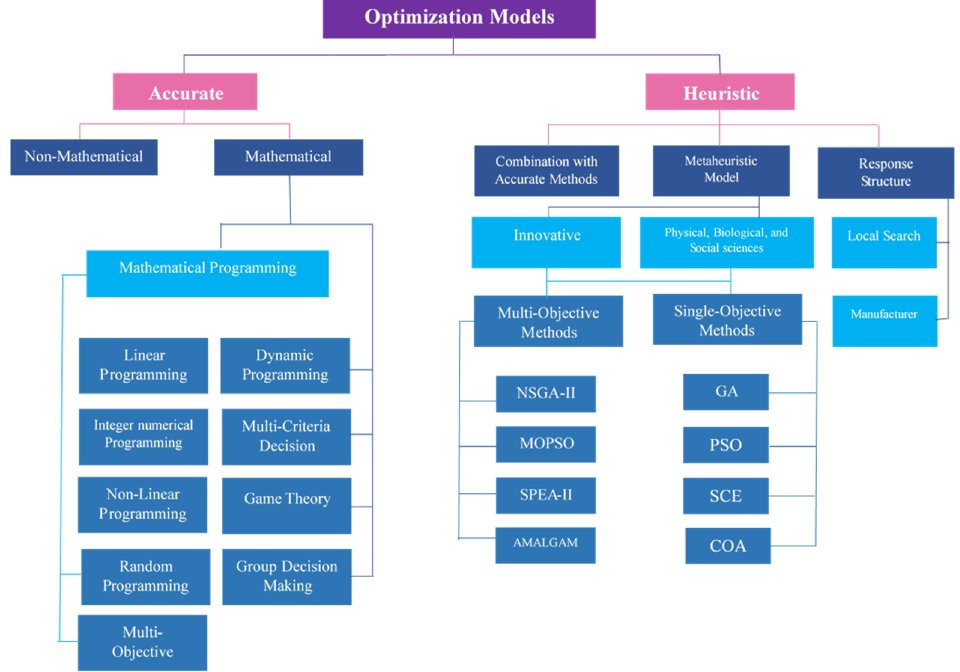
Figure 4. Various optimization algorithm approaches.